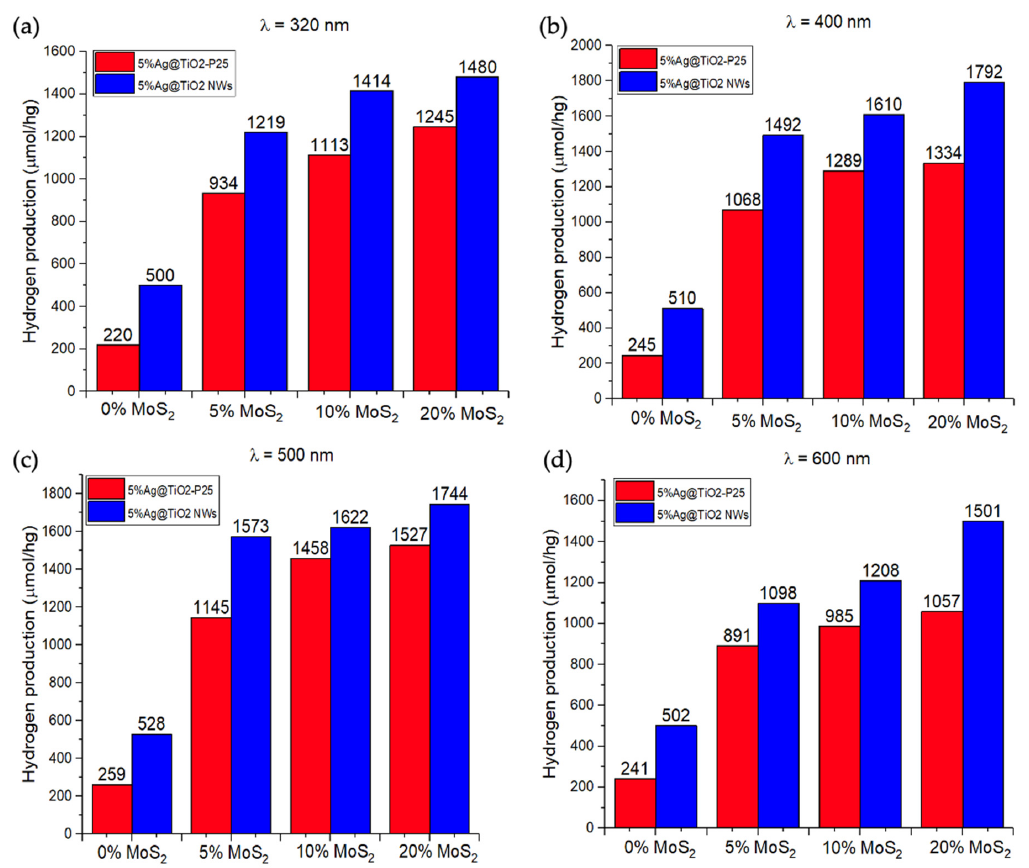
Figure 9. Hydrogen production of the TiO 2 -based catalysts with different MoS 2 loadings under ir- radiation at 320 nm ( a ), 400 nm ( b ), 500 nm ( c ) and 600 nm ( d ). Table 5. Maximum hydrogen production of the unmodified and modified TiO 2 -based catalysts, un- der irradiation at different wavelengths.